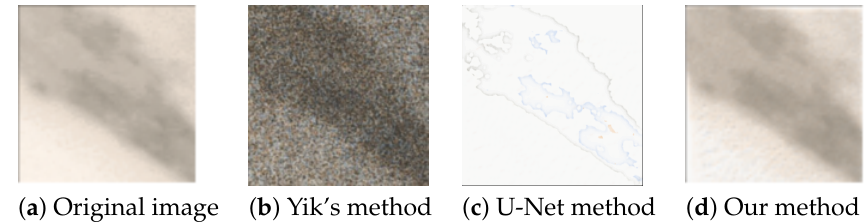
Figure 1. Rendering results of different multilevel halftone